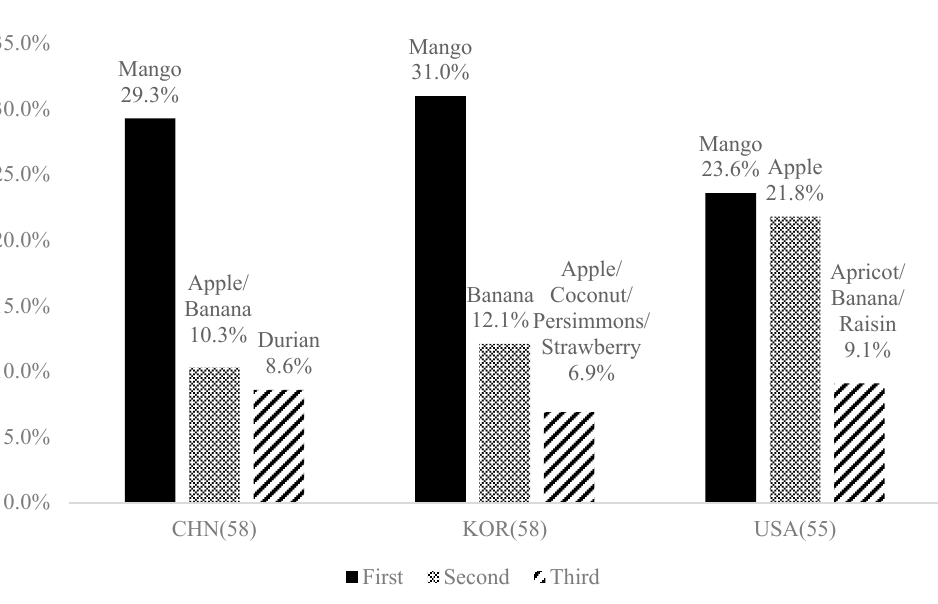
Figure 1. Top ranked dried fruits preferred by Chinese, Korean, and US consumers.